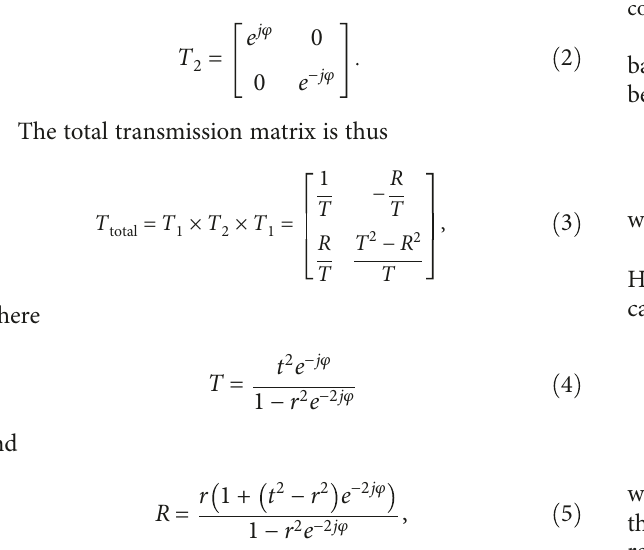
Figure 3: The simulated magnitude and phase of the re fl ection coe ffi cient of the square-loop FSS cell for various d